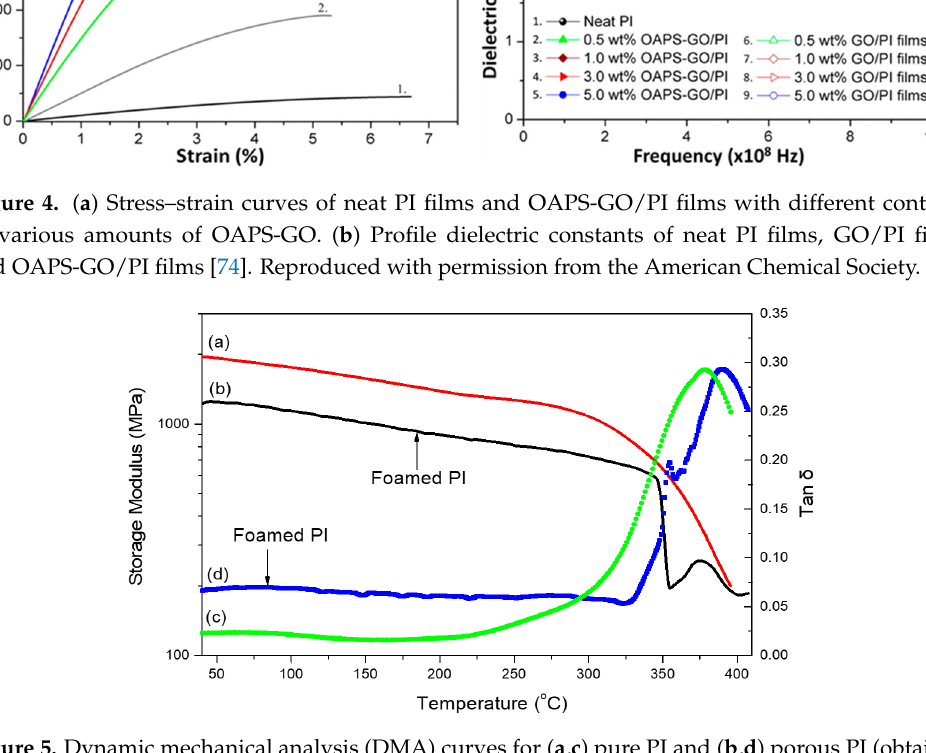
Figure 5. Dynamic mechanical analysis (DMA) curves for ( a , c ) pure PI and ( b , d ) porous PI (obtained from 10 wt % PEO-POSS), recorded at a heating rate of 2 °C/min [75]. Reproduced with permission from Elsevier.